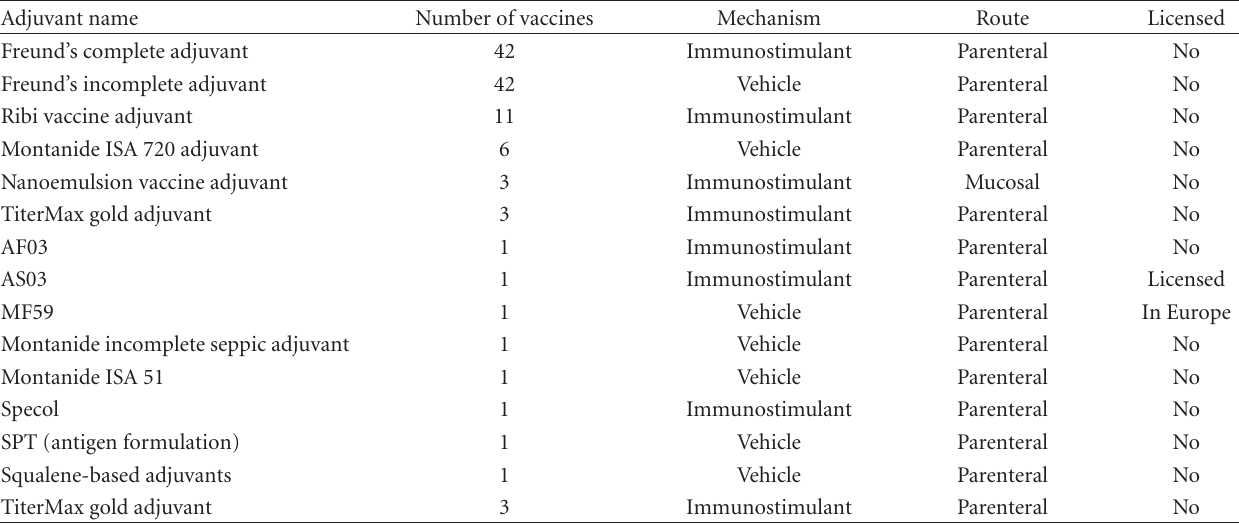
Table 3: Emulsion